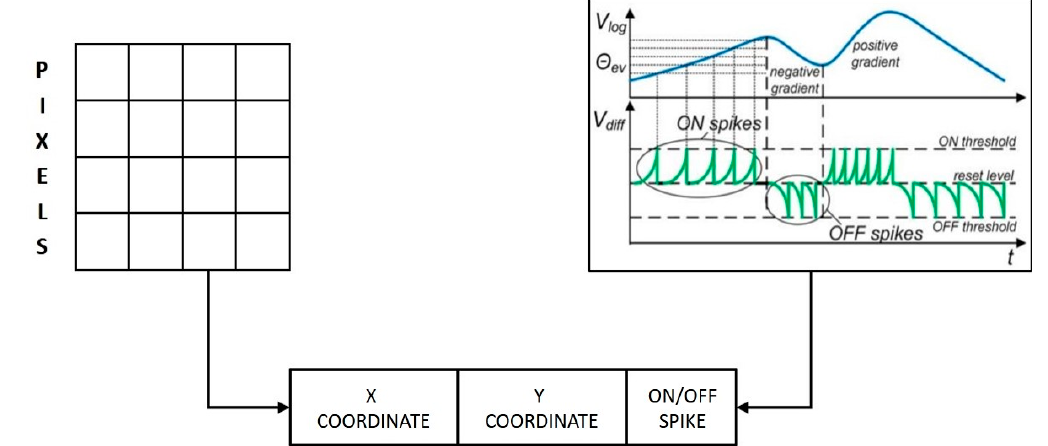
Figure 3. AER spike data format implemented in DVS [28] .